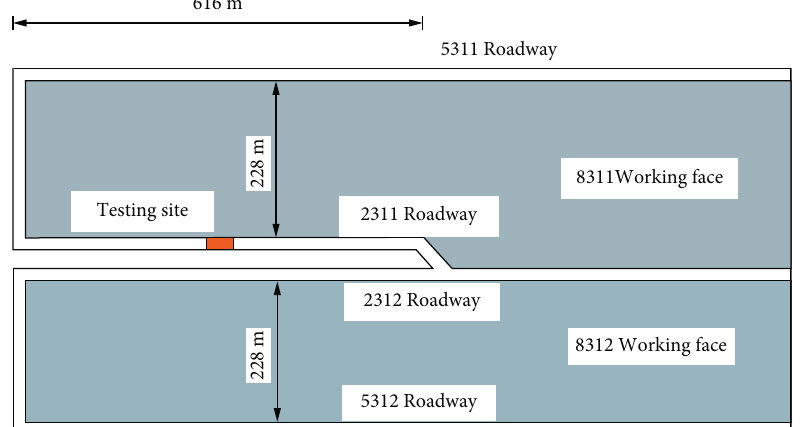
Figure 6: Working surface (plan).